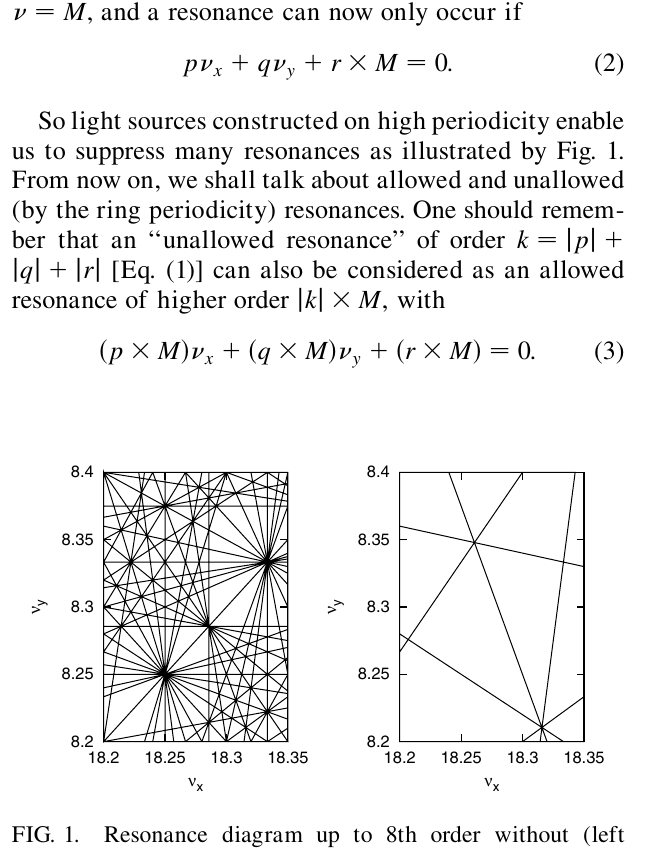
FIG. 1. Resonance diagram up to 8th order without (left panel) and with 12-fold periodicity (right